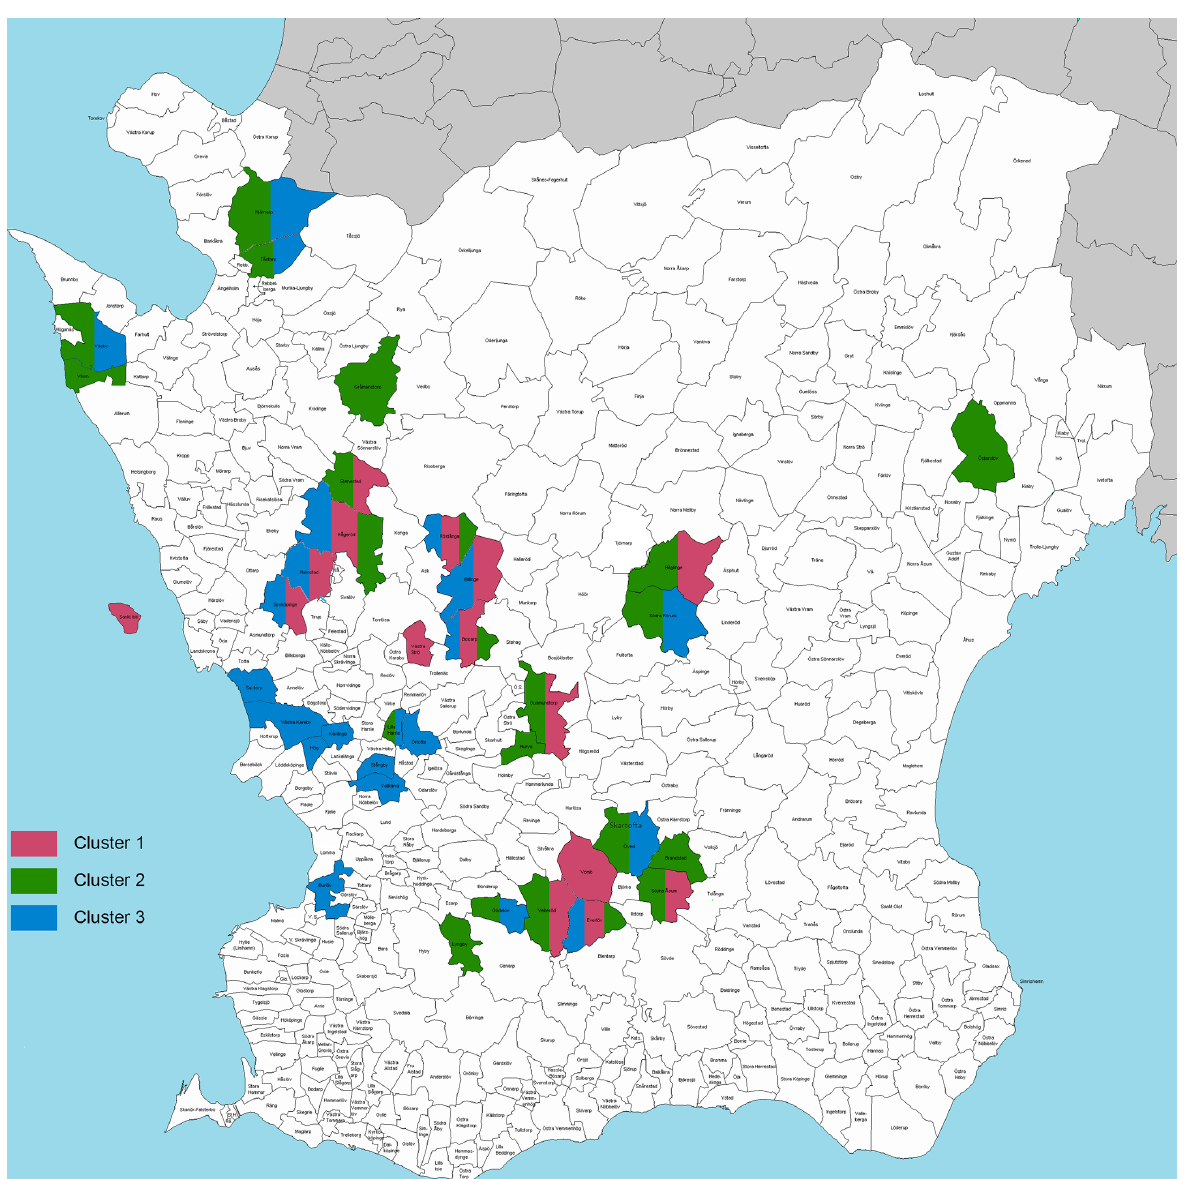
Figure 3. Geographical and administrative (parish) representation of each cluster. Source: author’s own edit of the parish map of Scania from Wikimedia Commons (Mrkommun,